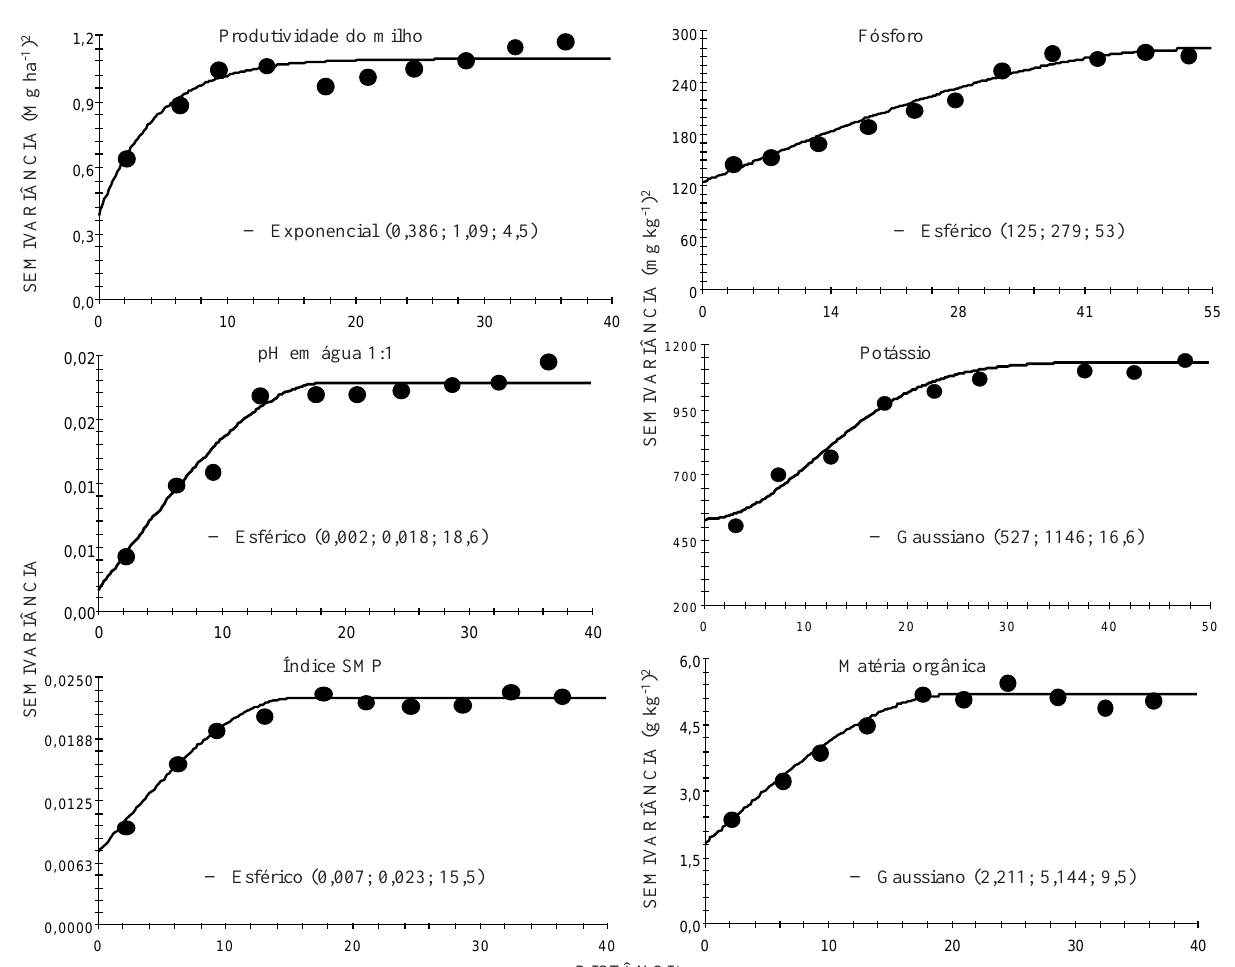
Figura 2. Semivariogramas das variáveis produtividade de milho, pH em água, índice SMP, fósforo disponível, potássio trocável e matéria orgânica do solo. (Valores entre parênteses são, respectivamente, efeito pepita, patamar e